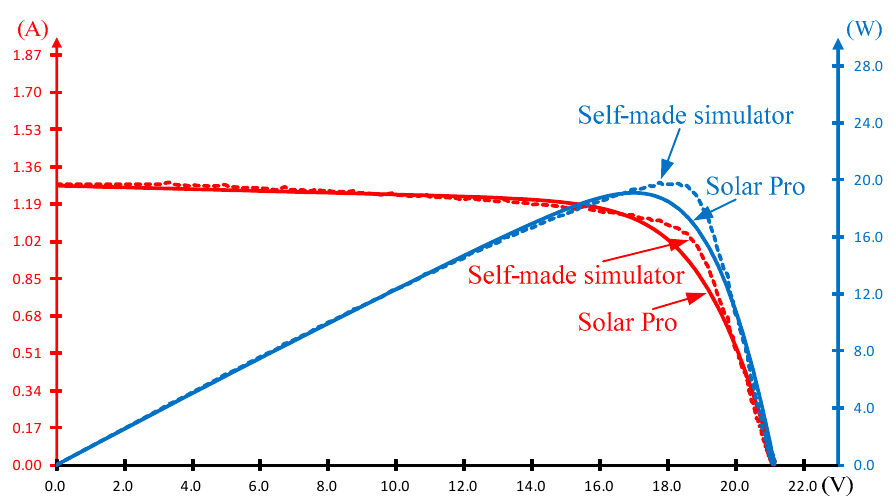
Figure 12. I-V and P-V characteristic curves of Solar Pro simulation and self-made simulator under 30% shading.